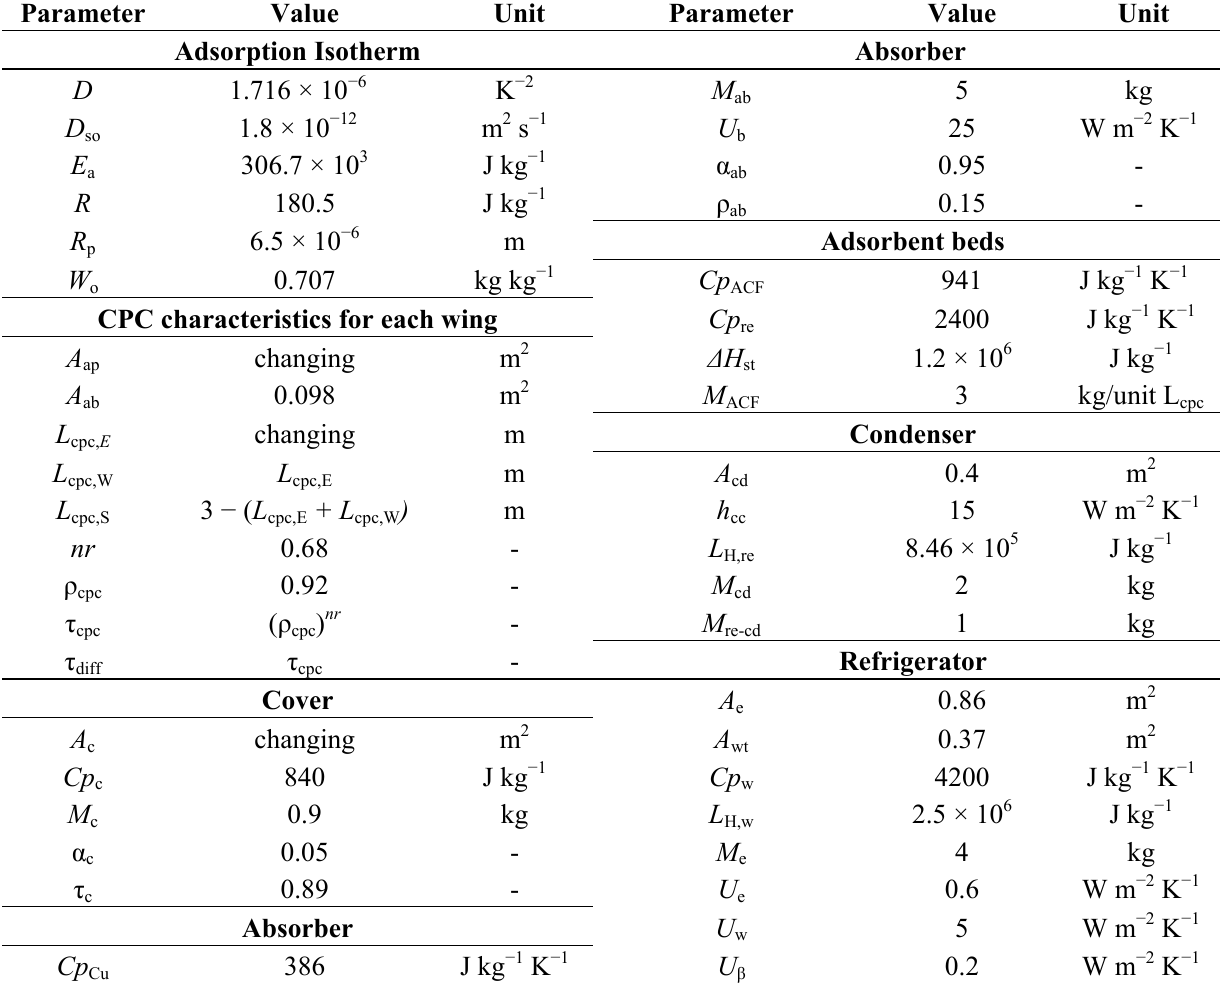
Table 1. Numeric values used in the